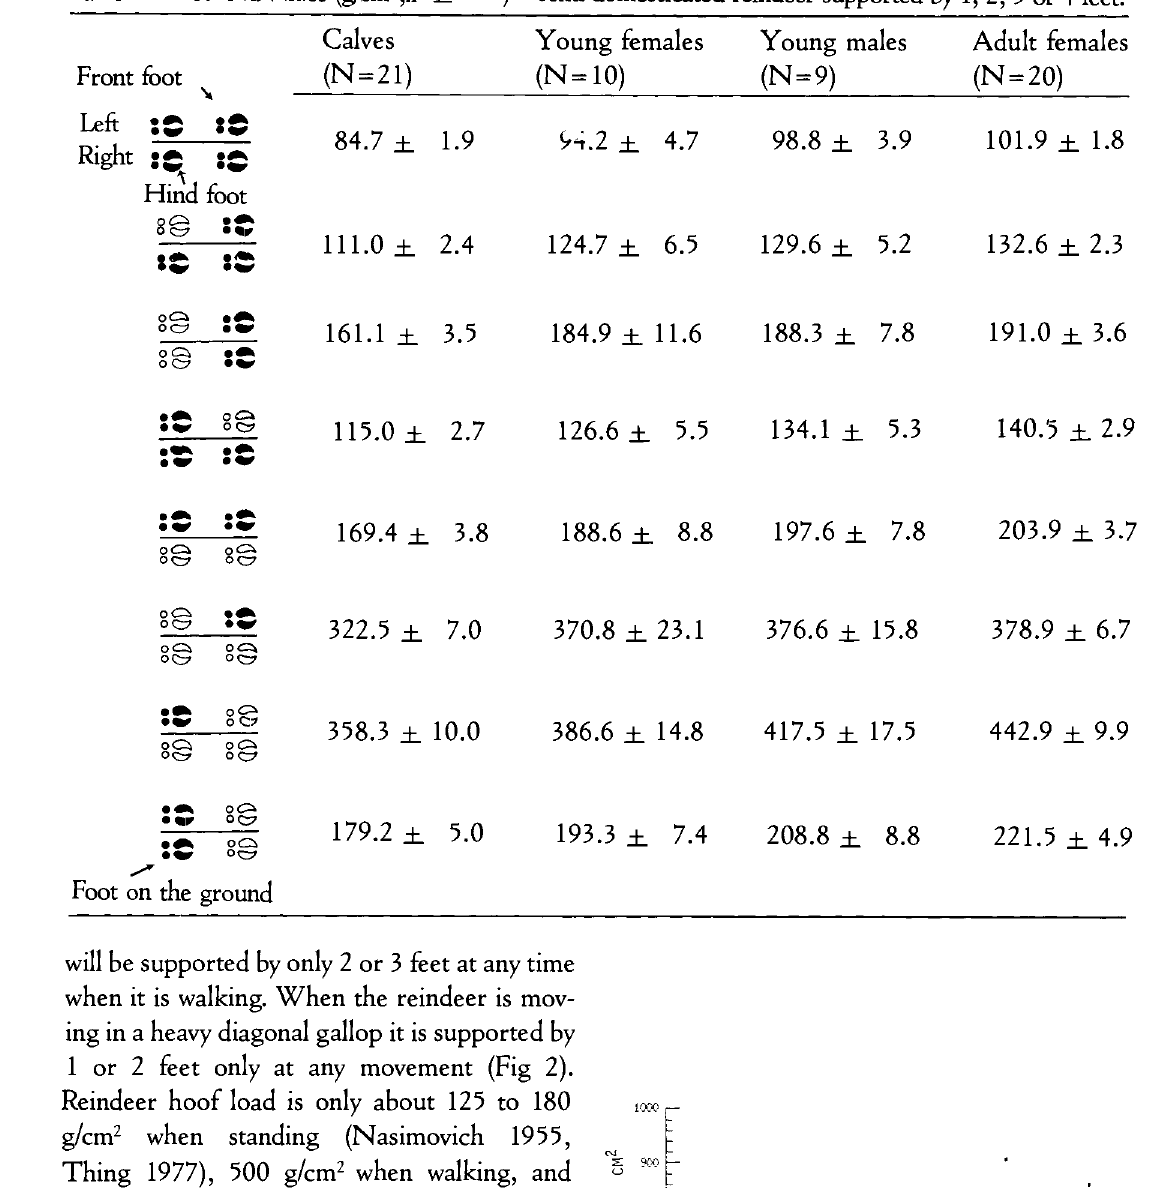
Table 2. Foot load values (g/cm 2 ,x ±_ S.E.)of semi-domesticated reindeer supported by 1, 2, 3 or 4 feet. Calves Young females Young males Adult females (N = 21) (N=10) (N=9) (N = 20) Front foot